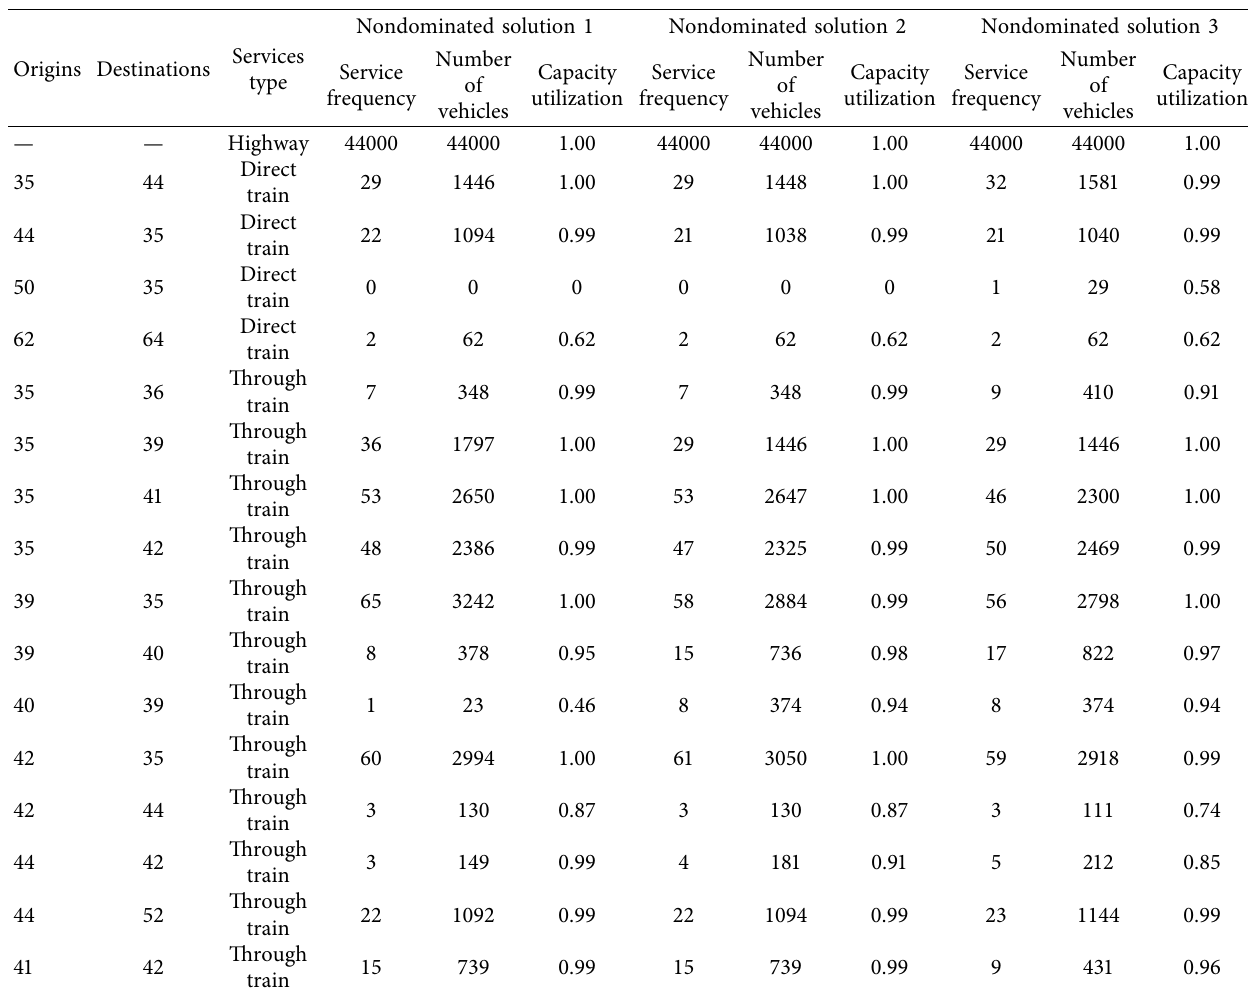
Table 5: Services operation plan of representative nondominated solutions.